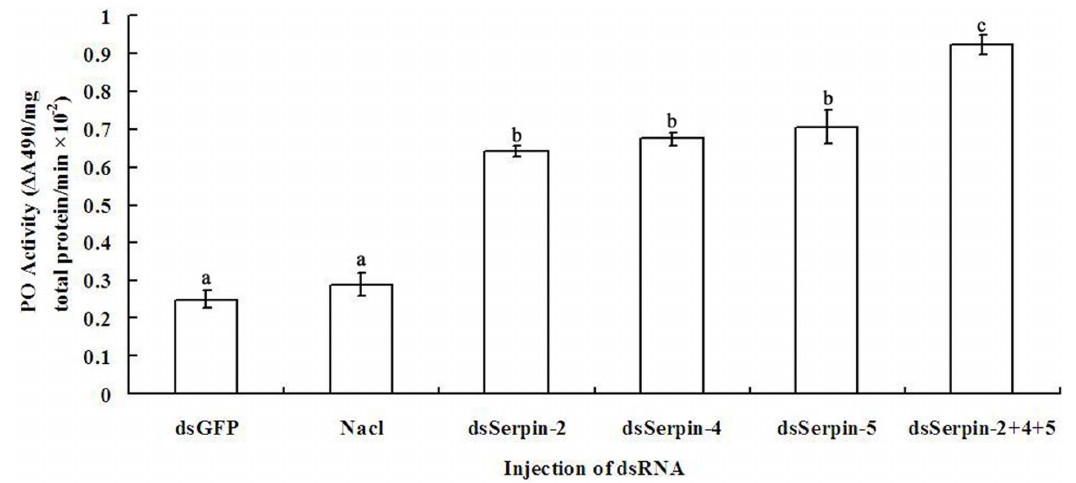
Figure 13. Hemolymph phenoloxidase (PO) activity in serpin silenced larvae of Plutellaxylostella . Hemolymph was collected at 24 h after the dsRNA injection (dsSerpin-2, dsSerpin-4 and dsSerpin-5). Larvae injected with dsGFP and saline buffer were used as control groups. The PO activity was measured using L-dopa and defined as D A 490 per mg total protein. Each value was shown as values 6 S.E.M of three independent experiments. Significant differences were indicated with different letters at P , 0.05.